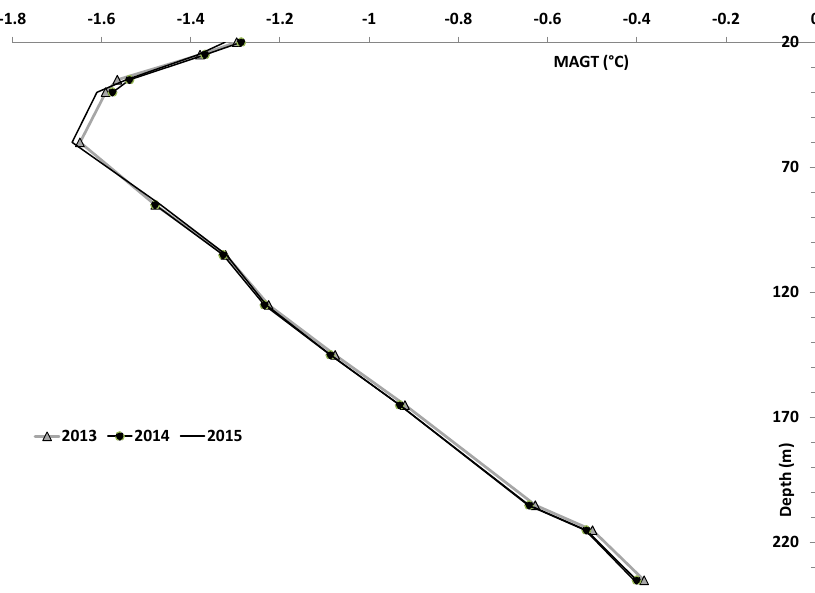
Figure 7. SSB mean annual ground temperature profiles in 2013, 2014 and 2015.